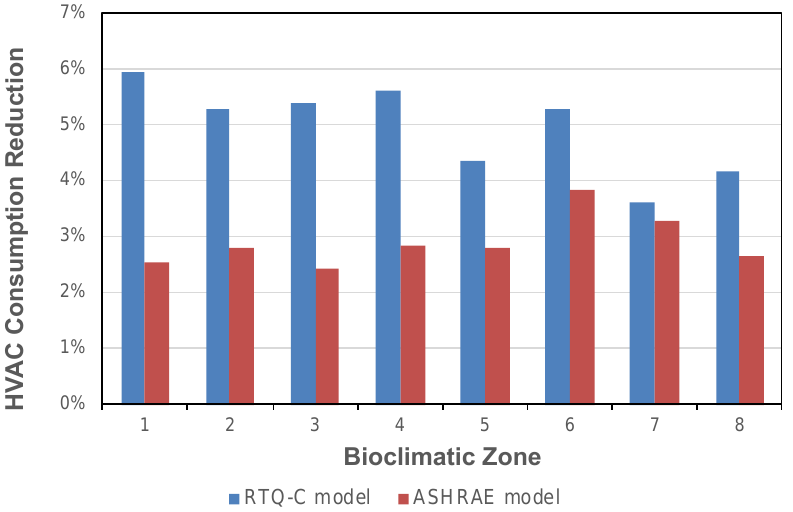
Figure 6. HVAC reduction for T chw isolated optimisation control.